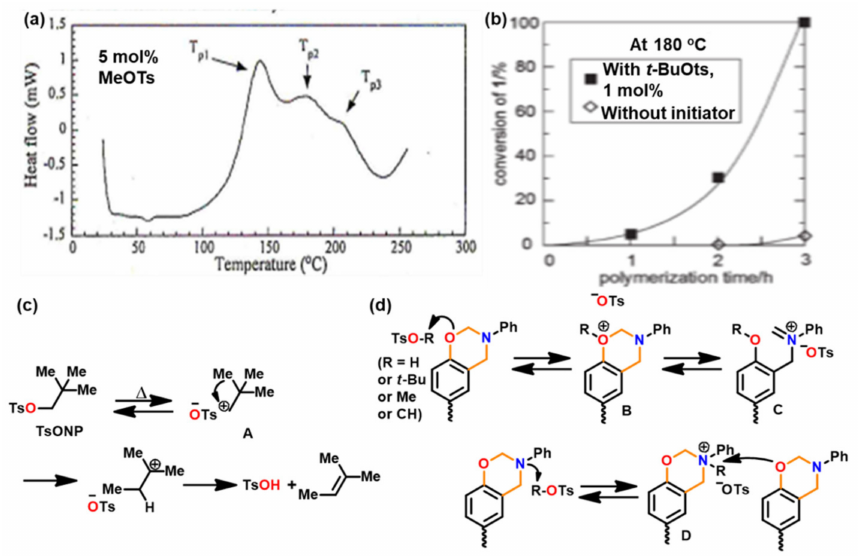
Figure 51. ( a ) Dynamic DSC thermogram of BA-a/5 wt% MeOTs [258]. Copyright 1999. Reproduced with permission from American Chemical Society. ( b ) Time conversion relationship for the tosylated initiated polymerization [290]. Copyright 2011. Reproduced with permission from Wiley Periodicals, Inc. ( c ) Mechanism for the formation of TsOH by thermal dissociation of CH-OTs (CH